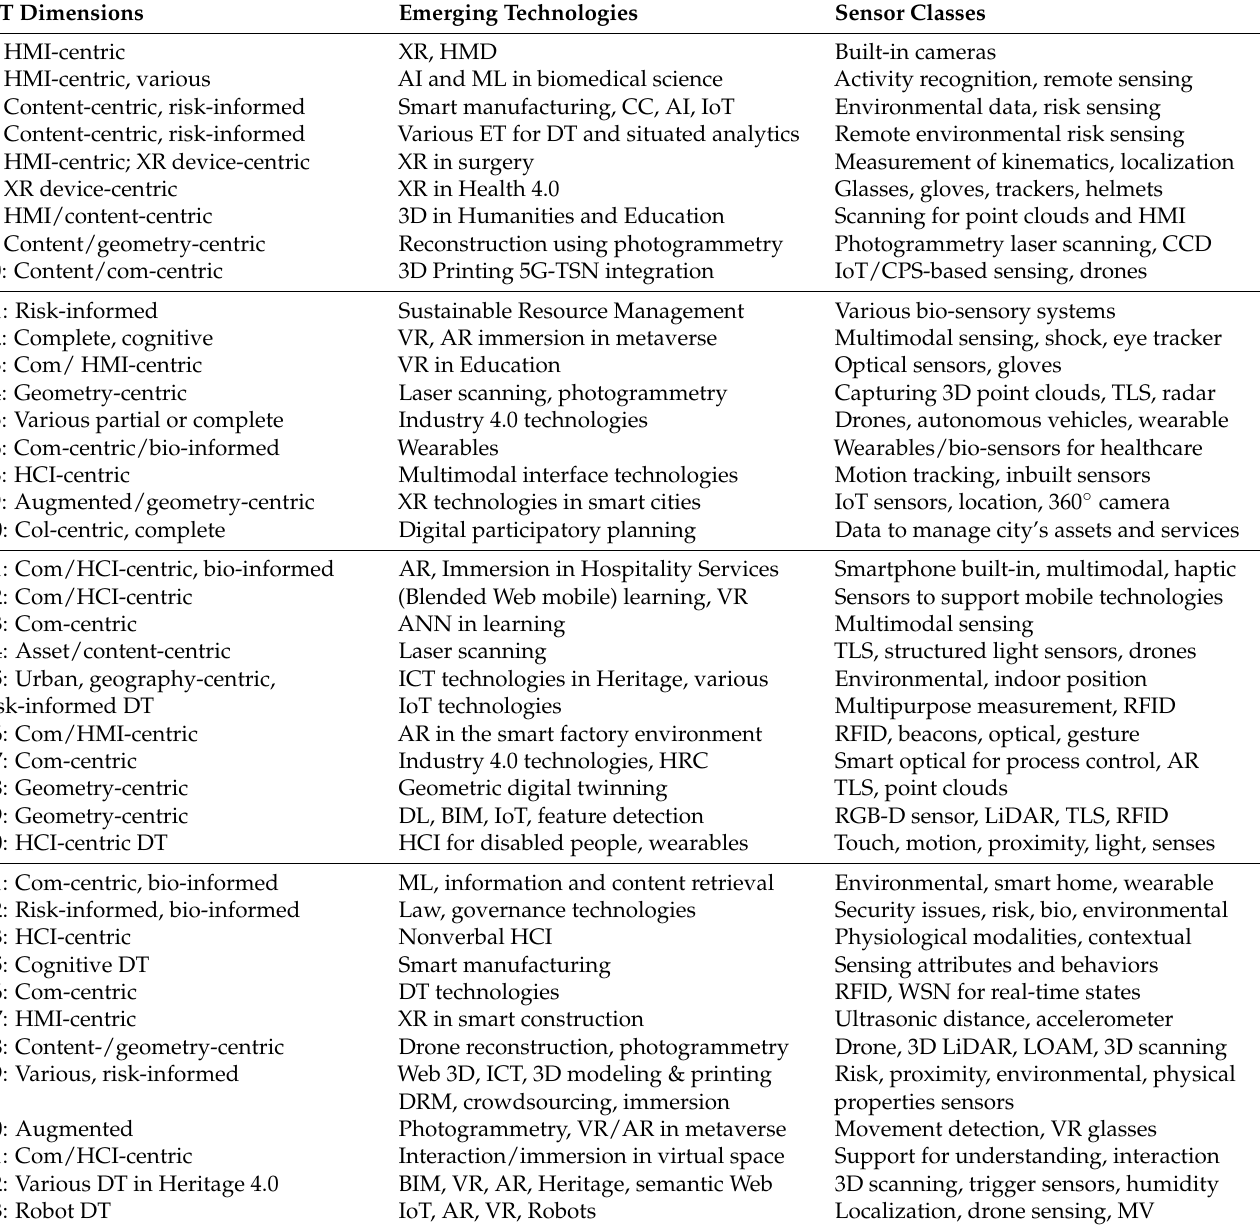
Table 2. DT dimensions, emerging technologies and sensor classes.